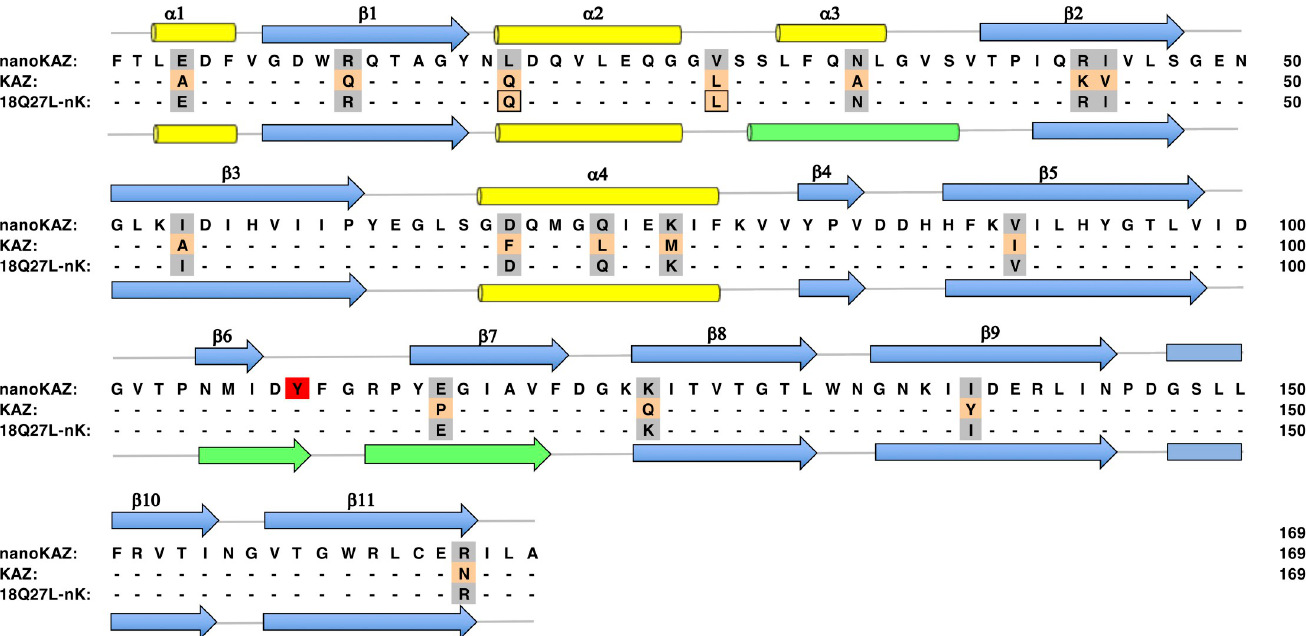
Fig 7. Comparison of the secondary structures between nanoKAZ and QL-nanoKAZ. The amino acid sequences of nanoKAZ and QL-nanoKAZ are shown with their positions of the secondary structure, and the letters highlighted in orange indicate the substituted 16 amino acid residues in wild KAZ to prepare reverse mutations of nanoKAZ. The cylinders and arrows indicate the regions of α -helices (yellow, α 1– α 4) and β -strands (blue, β 1– β 11), respectively. The green in the cylinder ( α 3) and the arrows ( β 6 and β 7) in QK-nanoKAZ indicate the structural differences compared to nanoKAZ. Tyr 109 is highlighted in red.